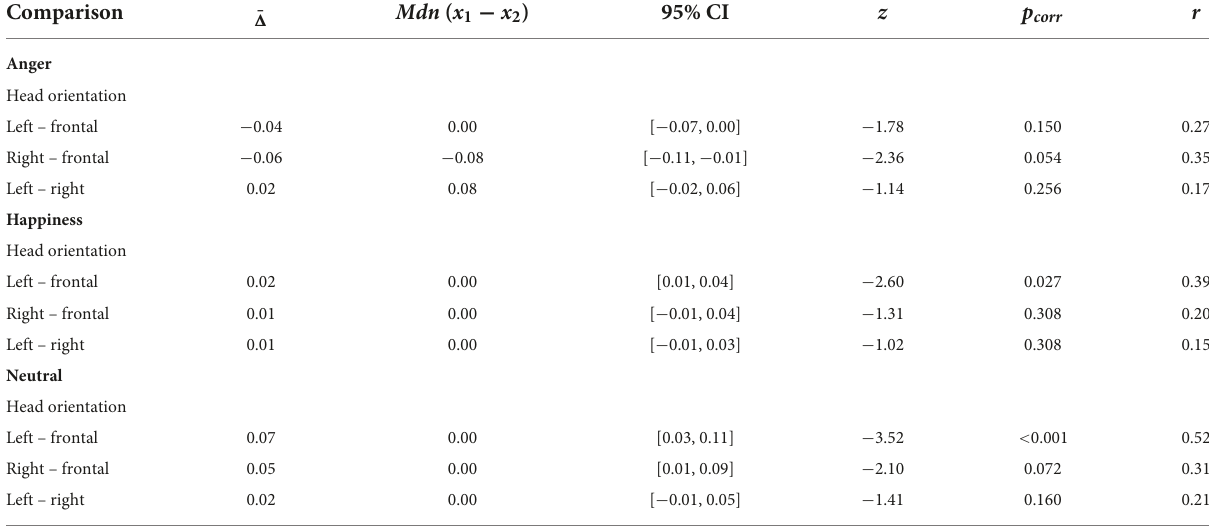
TABLE 2 Experiment 2: Results of the Wilcoxon signed-rank tests for correct emotion recognition (percentages given as decimals) ( N = 45). Comparison